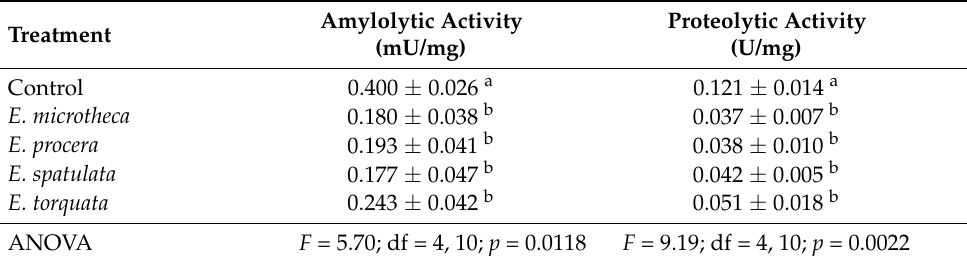
Table 6. The effects of low-lethal exposure to Eucalyptus essential oils (LC 30 concentration)